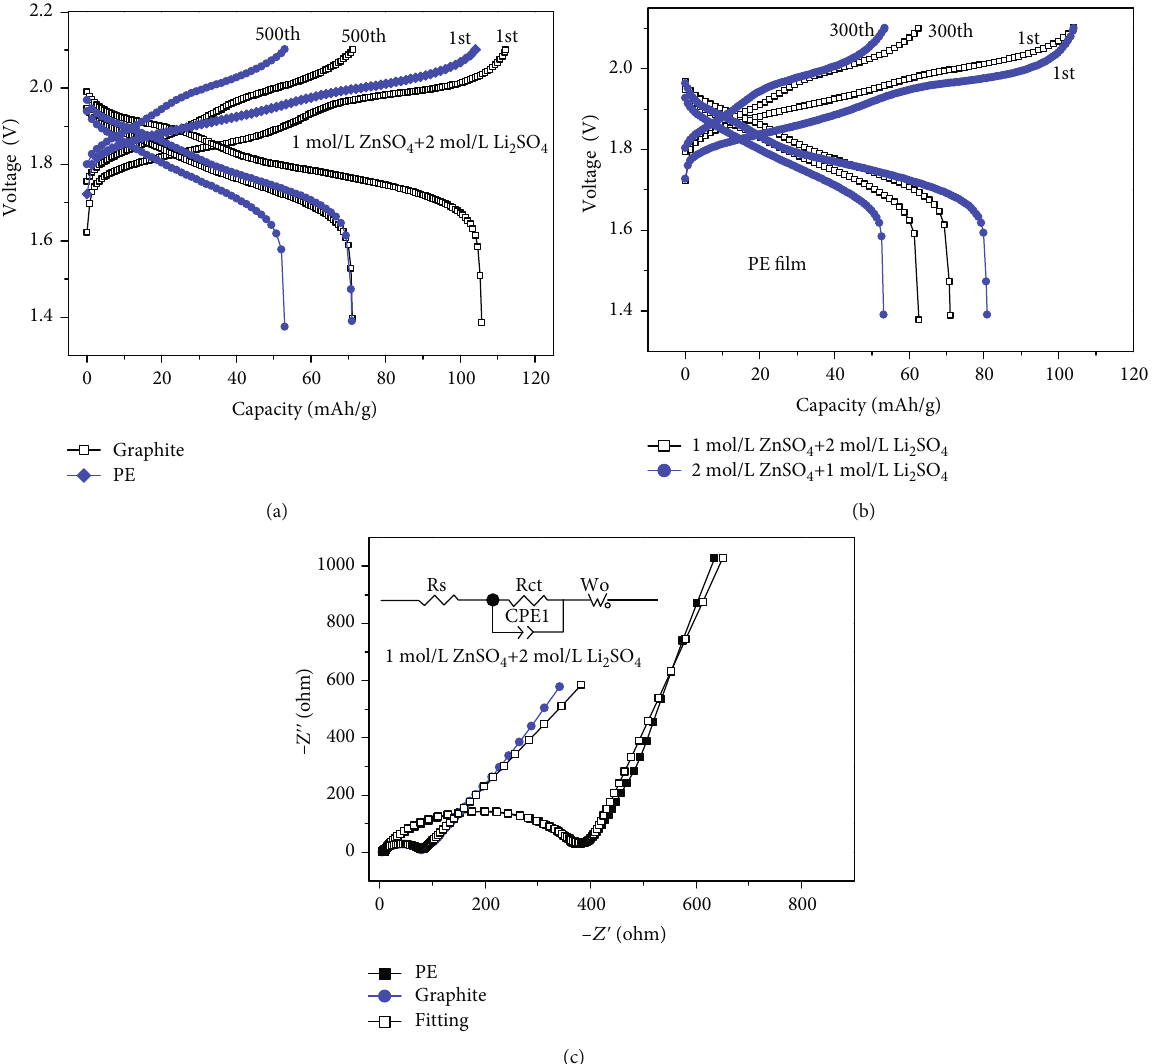
Figure 2: The charge/discharge curves of LiMn and (c) EIS spectra before cycling.